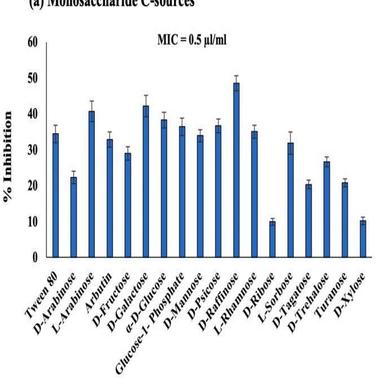
A. Percent inhibition on carbon sources metabolism by CIM (a) Monosaccharide and (d) Disaccharide carbon sources. B. In-silico and molecular mechanism of action of CIM against AFB1 biosynthetic genes (a) Interaction of receptors and ligand (b) Binding energy of interaction, gene expression analysis of (c) ver-1 by qRT-PCR and (d) Schematic representation of the anti-aflatoxigenic activity of CIM at the molecular level.